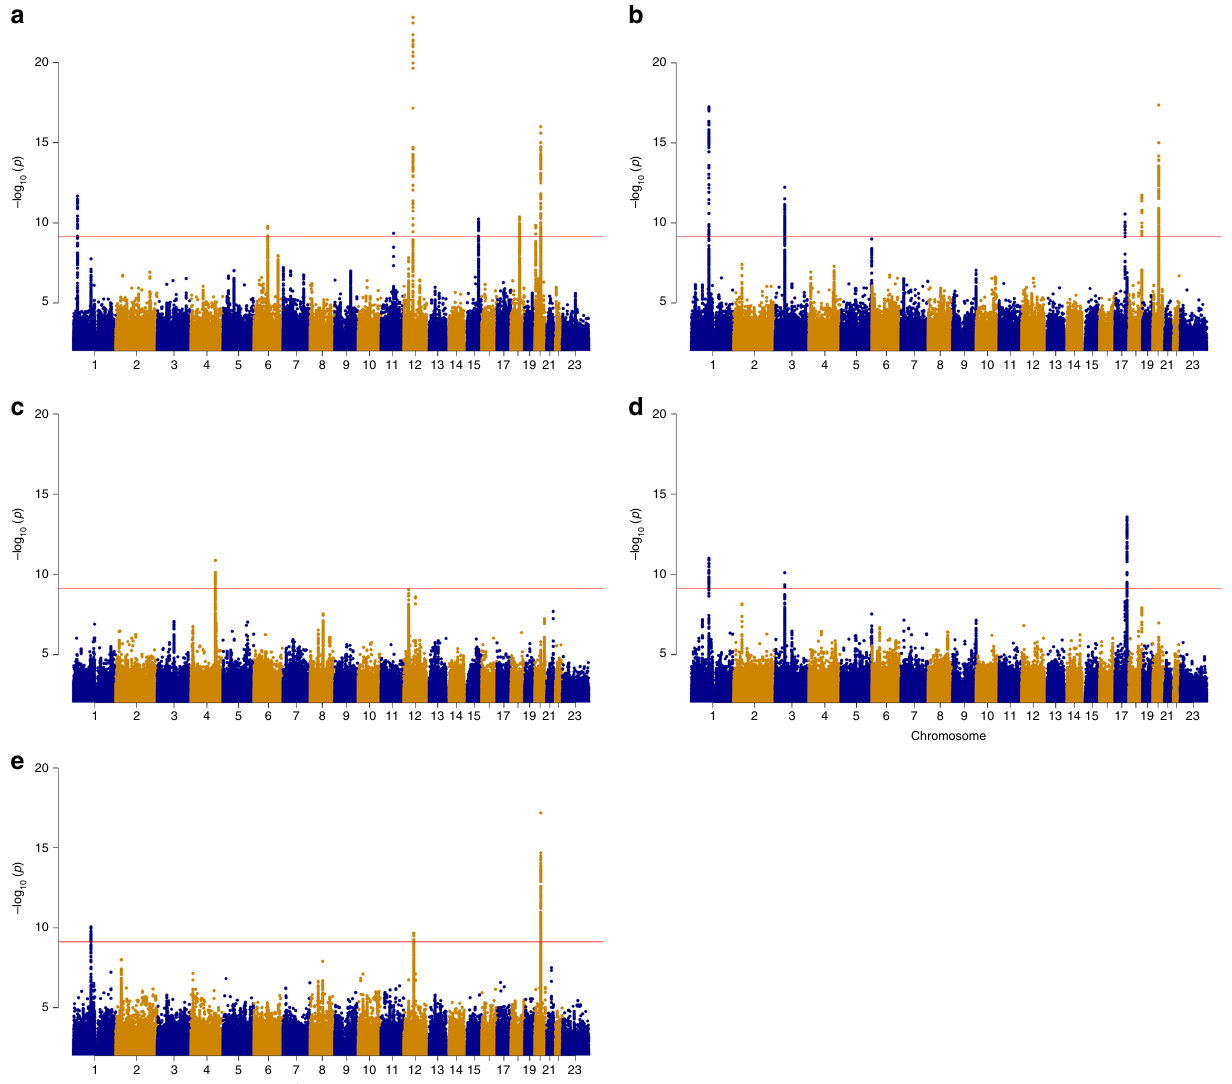
Fig. 1 Manhattan plots of the genome-wide analysis of the DXA bone area measures. The P values ( − log10) are plotted against their respective positions on each chromosome. Results are shown for all variants with signi fi cance level P < 0.001 and imputation information greater than 0.8. The red line denotes the signi fi cance level of intergenic variants, P ≤ 7.9 × 10 – 10. a Lumbar spine area (L1 – L4) ( N = 29,059), ( b ) Total hip area ( N = 28,900), ( c ) Femoral neck area ( N = 28,954), ( d ) Intertrochanteric/shaft area ( N = 28,936), ( e ) Trochanter area ( N = 28,944). Source data are provided as a Source Data fi